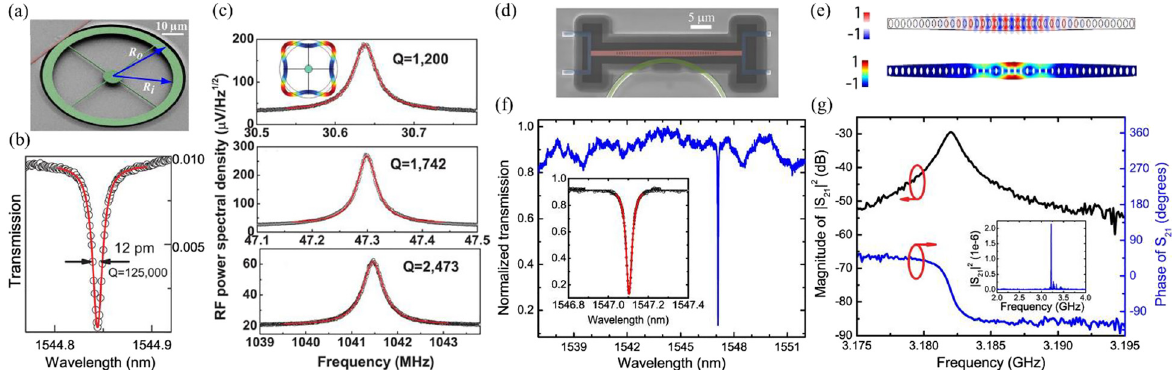
Figure 3: AlN-based integrated optomechanical devices. (a) False-color SEM image of microring-shaped optomechanical resonator. Suspended microring resonator is marked in green. Photonic coupling waveguide is marked in red. (b) One of the optical resonance spectral, showing optical cavity Q of 1.25 × 10 5 at resonance wavelength of 1544.85 nm. (c) Top, middle and bottom panel: zoom-in spectra of mechanical modes at 30.6, 47.3 and 1041.5 MHz, respectively. The fi tted curves give the mechanical cavity Q of 1200, 1742, and 2473, respectively. Inset in top panel shows the simulated displacement pro fi le for wine-glass mode at 30.6 MHz. (a) – (c) Adapted from [103], with the permission of AIP Publishing. (d) False-color SEM image of piezo-acousto-photonic crystal nanocavity. Piezo-acousto-photonic nanocavity, photonic coupling waveguide, and stress release structure are marked in red, green and blue color, respectively. (e) Top and bottom panel: simulated optical and mechanical mode pro fi le within the piezo-acousto-photonic crystal nanocavity. (f) Optical spectrum of PhC cavity. Intrinsic cavity Q can be obtained as 1.2 × 10 5 at 1547.1 nm. Inset shows the zoom-in view near the optical resonance. (g) S 21 magnitude and phase of the piezo-acousto-photonic crystal nanocavity. Inset shows S 21 magnitude at the frequency between 2.0 and 4.0 GHz. (d) – (g) Adapted from [104], with the permission of AIP